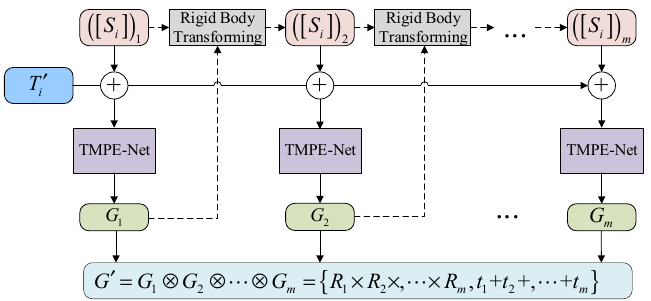
Figure 5. The iterative estimation of rigid body transformation.